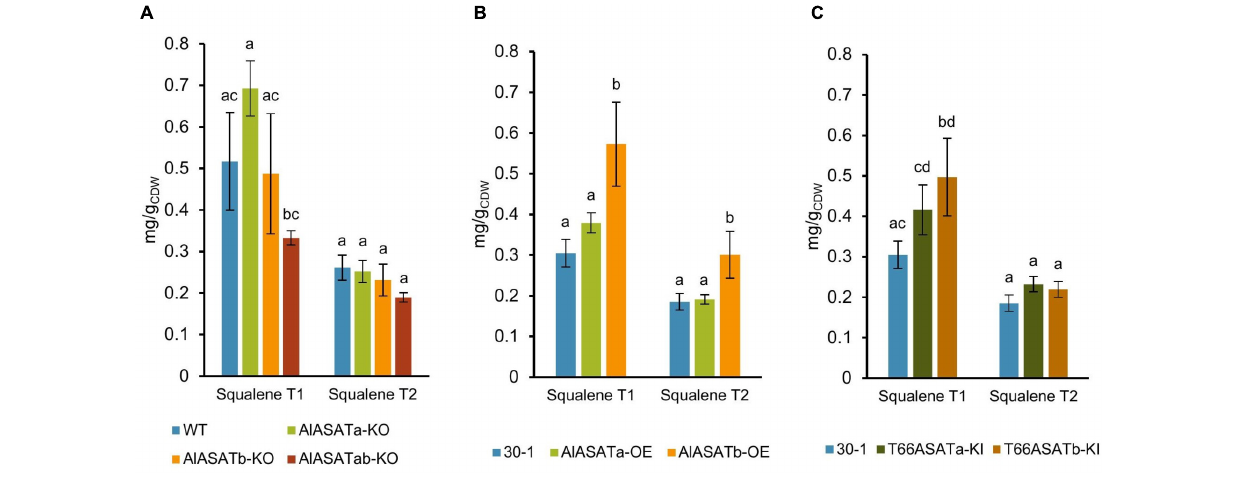
FIGURE 6 | The production of squalene from the (A) KO, (B) OE, and (C) KI strains in milligram per gram cell dry weight (mg/g CDW ). All data are expressed as the mean of the triplicates originating from three independent cultures, except data from T66ASATb-KI at T2, which originate from two independent cultures; Error bars represent the standard deviation. The bars are separated into groups, each with a particular SE and time points. For each group, the bars with all the lowercase letters different on the top are statistically significantly different from each other ( P < 0.05), based on one-way analysis of variance (ANOVA), followed by post hoc Tukey